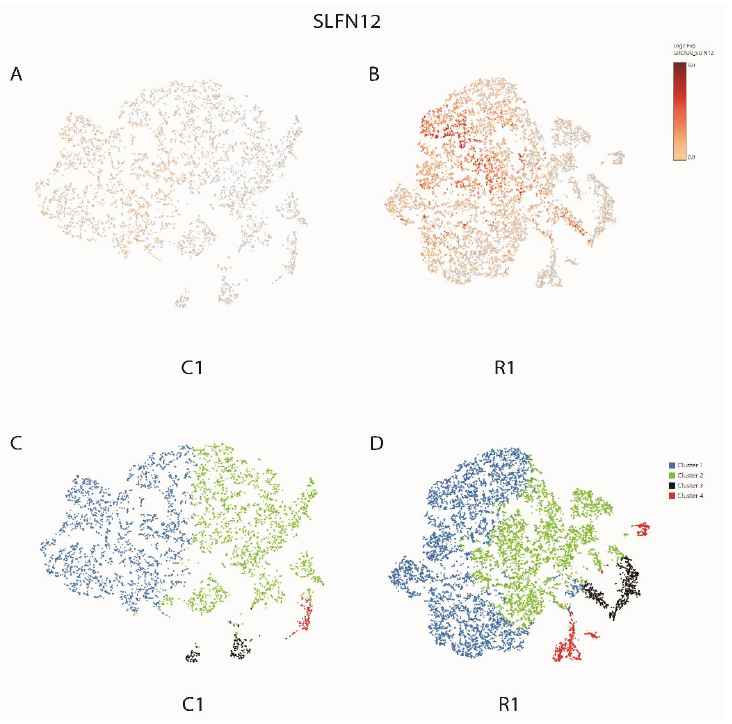
Figure 7. Single-cell expression of SLFN12 in ( A ) C1 and ( B ) R1. Log2 expression in 0 – 9.0. ( C ) Four K-means clusters of C1. ( D ) Four K-means clusters of R1.